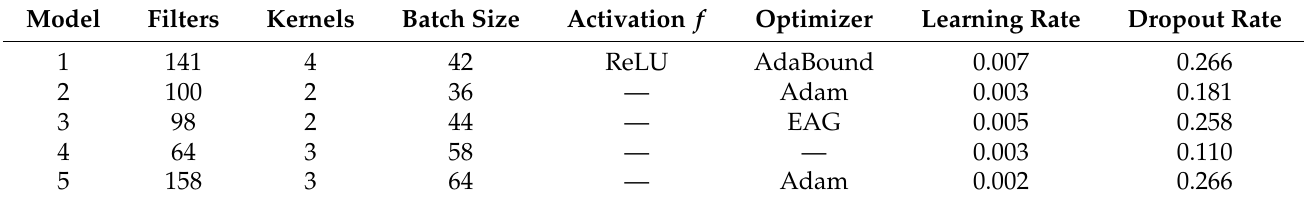
Table 4. Models selected based on Bayesian